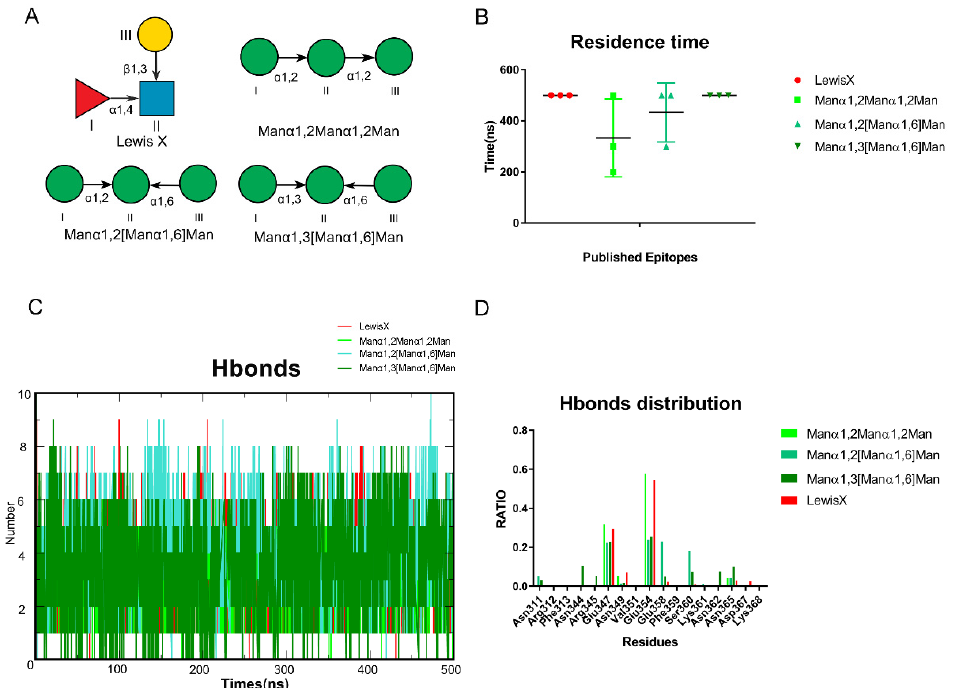
Figure 2. Experiments reported glycan epitopes recognized by DC-SIGN performed through MD simulations. ( A ) Known Glycan epitopes that bind with DC-SIGN.0 LewisX, Man α 1,2Man α 1,2Man, Man α 1,2[Man α 1,6]Man, Man α 1,3[Man α 1,6]Man. ( B ) Residence time of these systems in triple replica. ( C ) The number of hydrogen bonds between the oligosaccharides and protein along the trajectories. Man α 1,2[Man α 1,6]Man, Man α 1,3[Man α 1,6]Man formed more than LewisX and Man α 1,2Man α 1,2Man. ( D ) Four oligosaccharides hydrogen bonds distribution RATIO along each trajectory. The LewisX and Man α 1,2Man α 1,2Man are alike. Man α 1,2[Man α 1,6]Man, Man α 1,3[Man α 1,6]Man shows higher similarity. Lewis X in red, Man α 1,2Man α 1,2Man in light green, Man α 1,2[Man α 1,6]Man in green, Man α 1,3[Man α 1,6]Man in dark green.